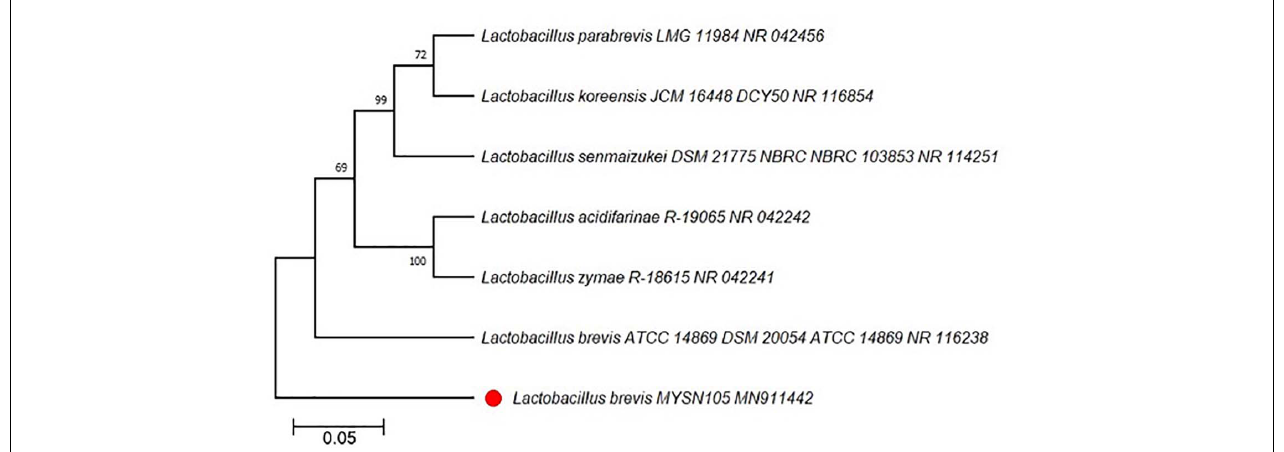
FIGURE 1 | Phylogenetic tree showing the relative position of Lactobacillus brevis MYSN105 MN911442 marked with red taxon marker, using the neighbor-joining method of partial 16S rDNA sequences. Reference strains used for the comparison are labeled with their accession numbers of the 16SrDNA sequences. Bootstrap values for 100 replicates are shown at the nodes of the tree, using MEGA X 10.1.8. The scale bar corresponds to 0.05 U of the number of base substitutions per site.